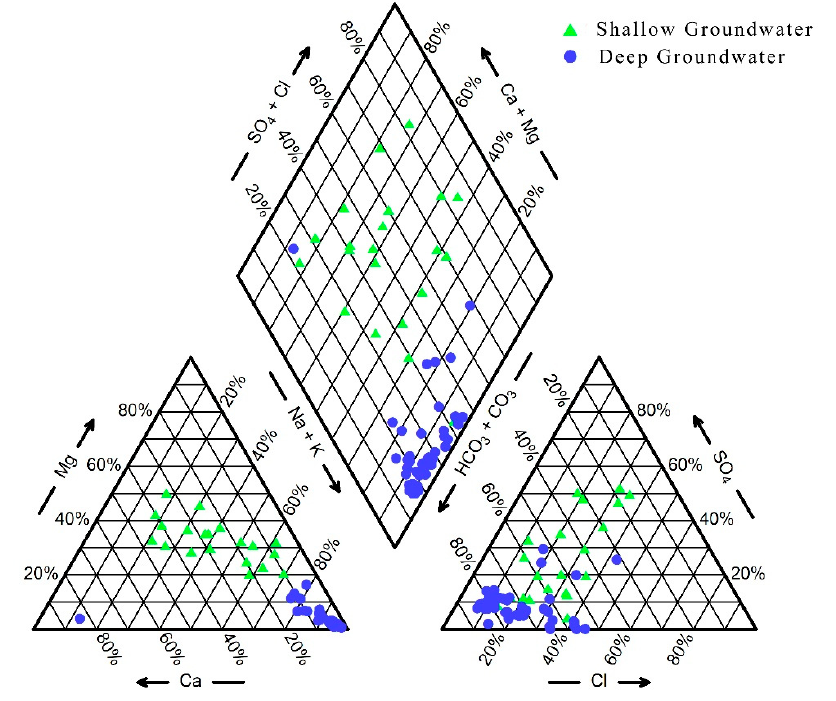
Figure 3. Piper diagram showing the groundwater hydrochemical types.